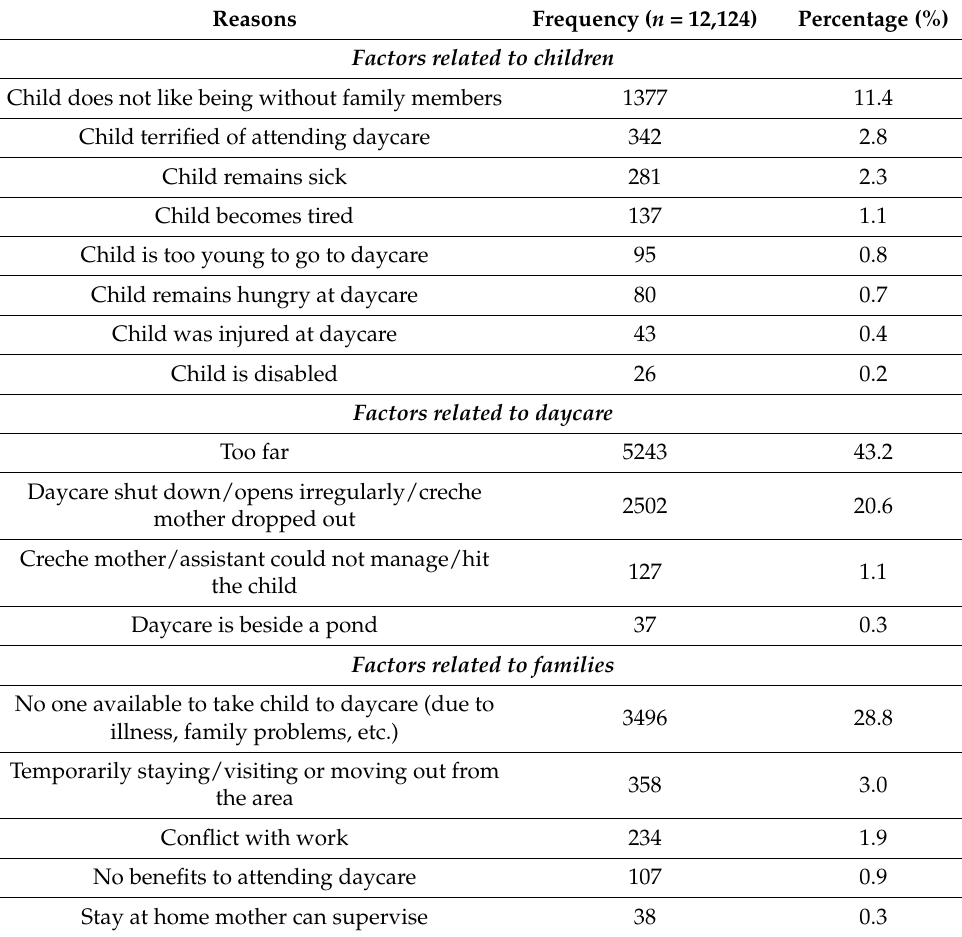
Table 3. Reasons for discontinuing daycare as stated by respondents 1